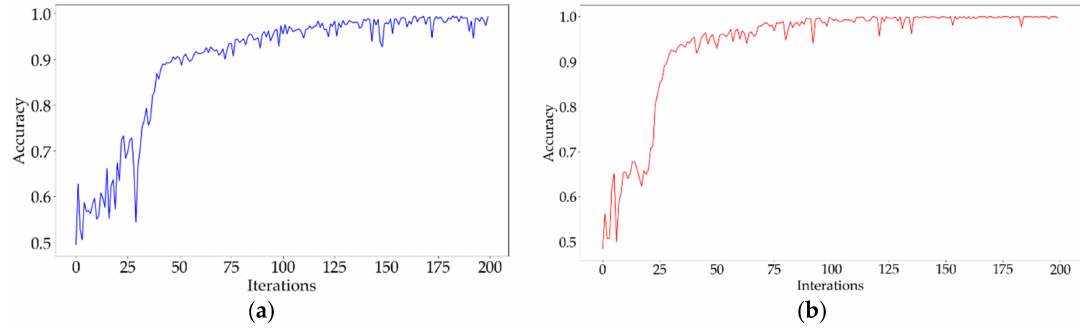
Figure 11. The accuracies of models under di ff erent mass of ice accretion condition: ( a ) 15 kg ice on each blade, ( b ) 30 kg ice on each blade.